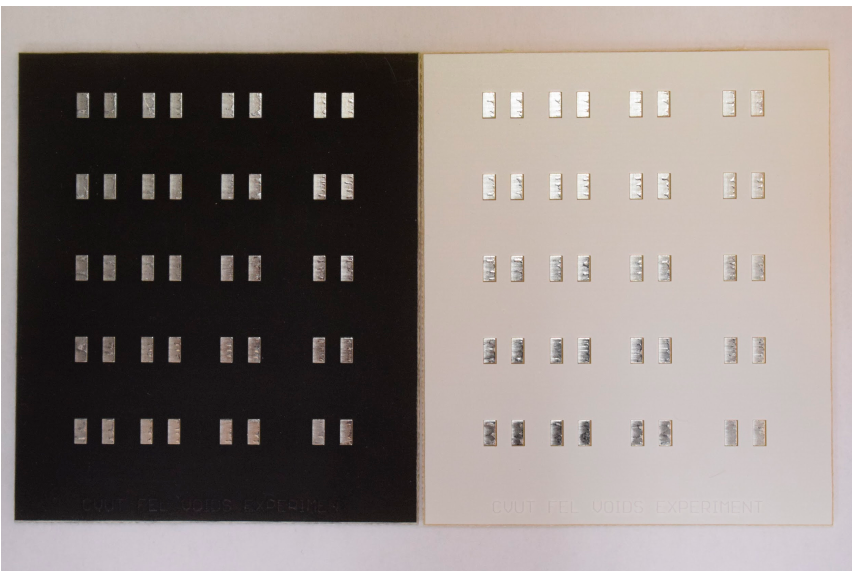
Figure 2. Design of PCB test board. Black solder mask with HASL surface finish ( left ); white solder mask with HASL surface finish ( right ).